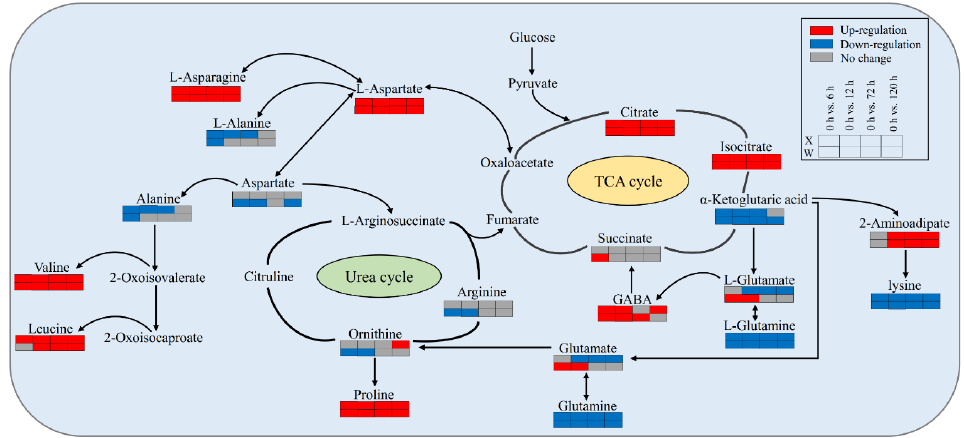
Figure 8. Analysis of the metabolic network in E. sibiricus under drought stress. The proposed metabolic pathways are based on the literature and KEGG database. Red indicates a significant increase, blue indicates a significant decrease, and gray indicates no significant change.